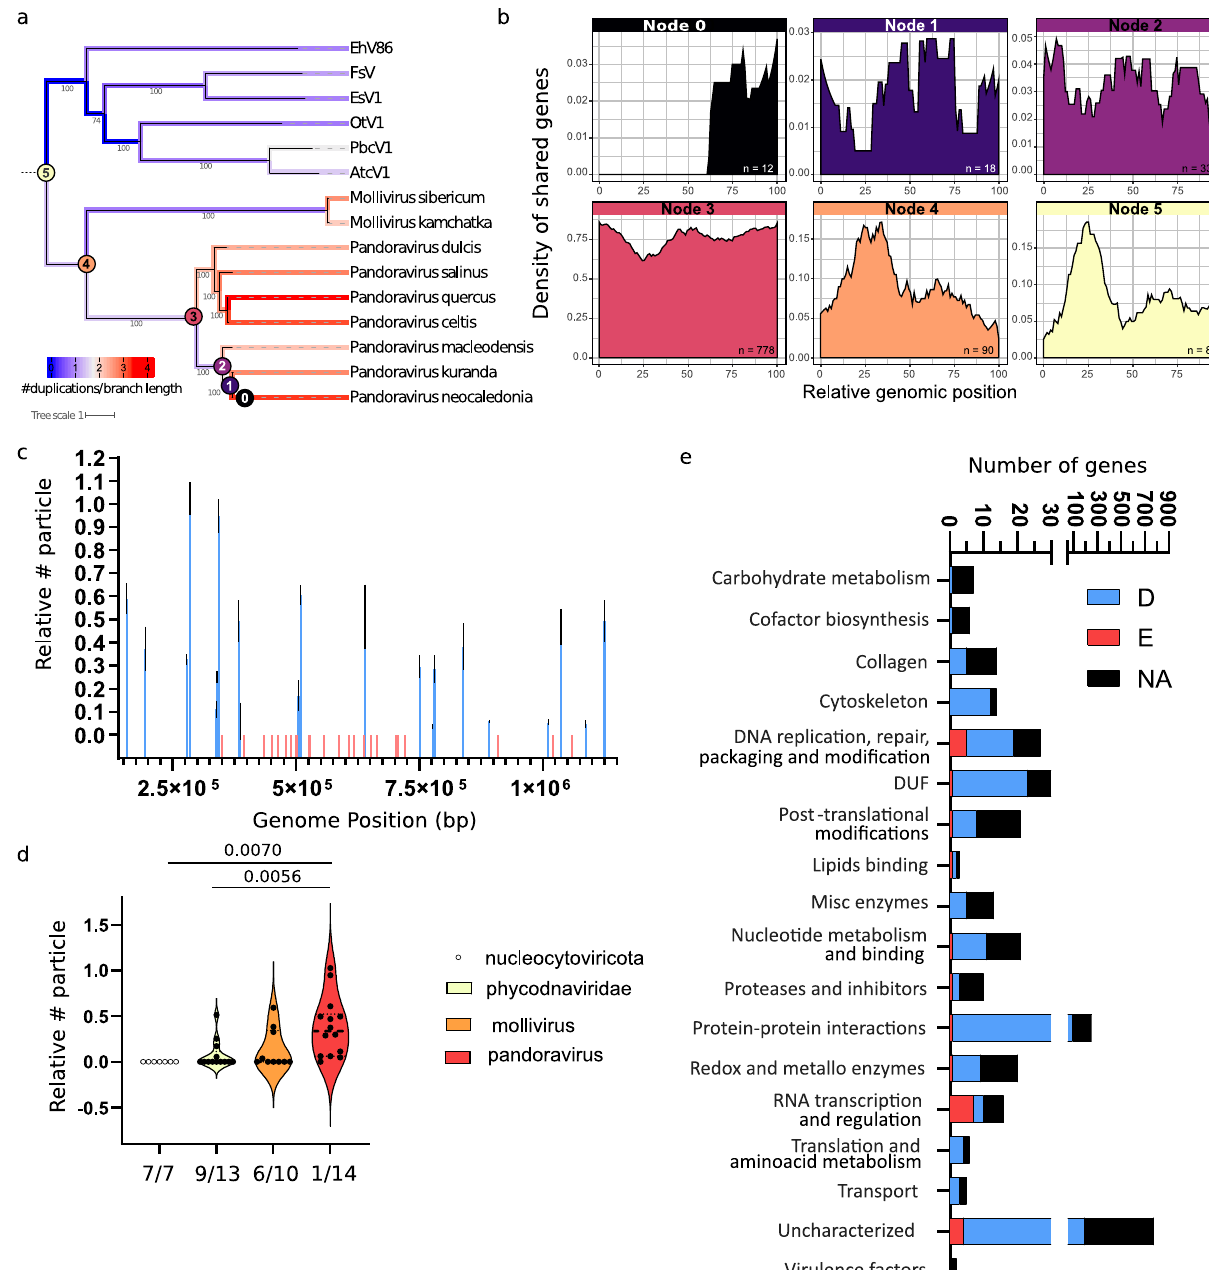
Fig. 6 | Pandoravirus genome organization keeps traces of their smaller ancestors.a Phylogenetictreeof Phycodnaviridae , Molliviridae and Pandoraviridae computed from a concatenated multiple alignment of 435 orthologous proteins present in atleast two viruses. Bootstrap values werecomputed usingthe ultrafast boostrap method 64 . Number of gene duplication events along the branches from the phylogenetic tree are also shown. The numbers were normalized by branch length,log10transformedandcolor-codedfromblue(lownumberofduplications) tored(high). b Densityof P.neocaledonia genesalongthegenomeaccordingtoits predicted ancestry. The P. neocaledonia genes were classi fi ed based on the pre- sence of homologs in other viruses and color-coded from the corresponding ancestral node shown in panel a . c Quanti fi cation of the number (#) of viruses produced upon knock-out of genes located at the essential core of the genome relative to viruses producedinoff-target gRNA expressing amoebasand ranked by their position in the genome. Data correspond to the mean±SD of 3 independent